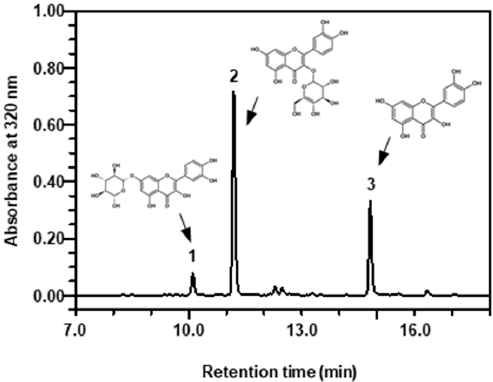
Figure 2. HPLC chromatogram of quercetin derivatives in marigold petals; 1, Quercetin-7- O -glucoside (Q7G); 2, Quercetin-3- O -glucoside (Q3G); 3, Quercetin.